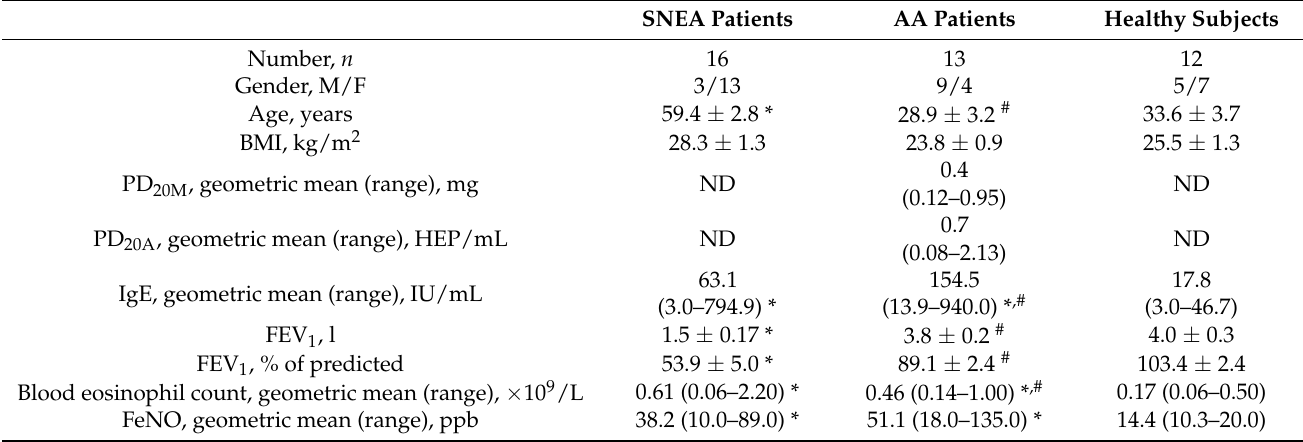
Table 2. Demographic and clinical characteristics of the study